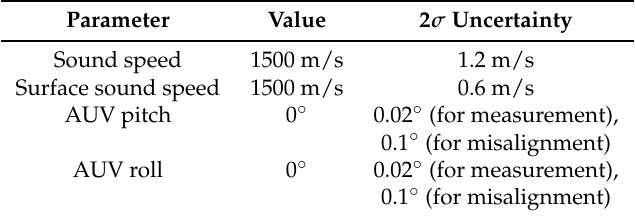
Table 8. Values of parameters necessary for uncertainty assessment.